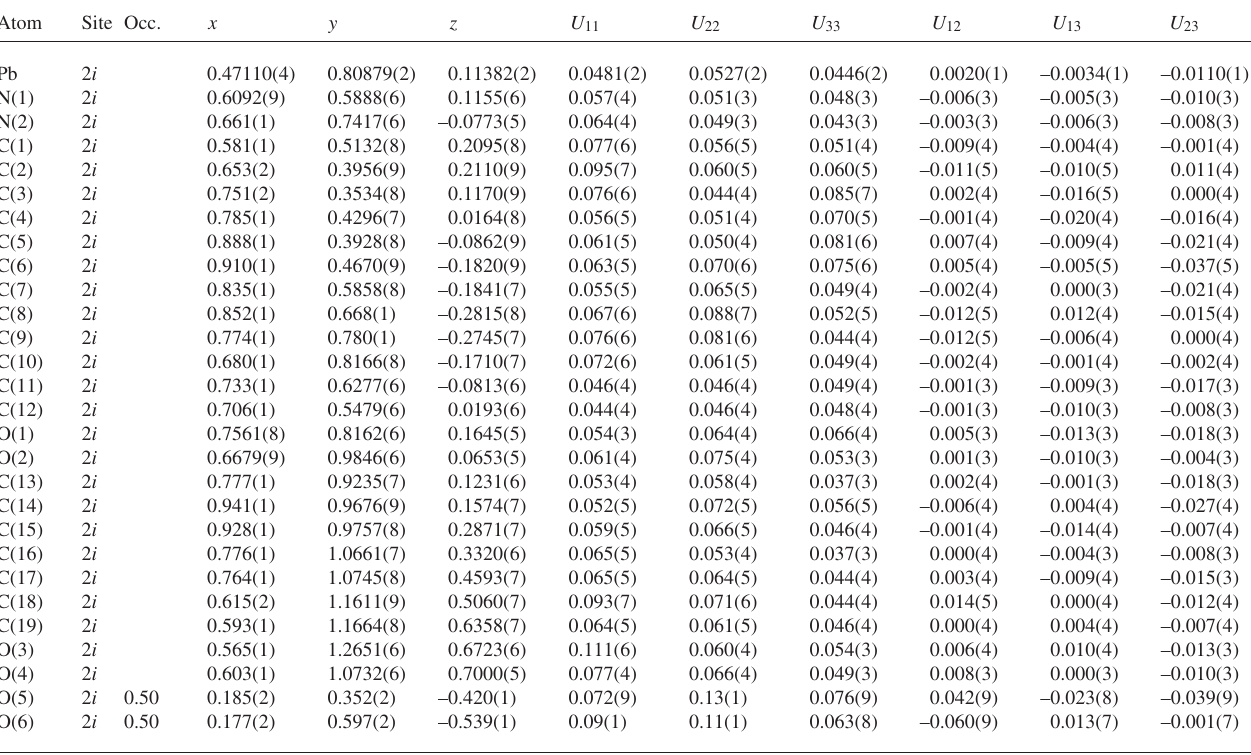
Table 3. Atomic coordinates and displacement parameters (in Å 2 )